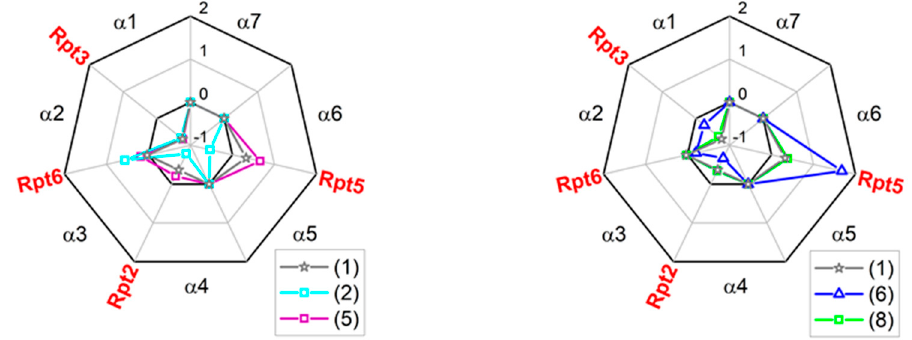
Figure 7. TAT1 derivatives competed with selected C-terminal tails of Rpt (Regulatory Particle ATPases) subunits for binding to specific α face pockets. The scores presented in radar plots were calculated as ((relative activation by the [x] and Rpt tail)-(theoretical sum of activation by [x] and Rpt tail)) / (theoretical sum of activation by [x] and Rpt tail), where [x] represent any TAT peptide. Score = 1 indicates a pure additive e ff ect of Rpt and TAT peptides, score < 1 suggests competition, score > 1 hints at synergy. (5) competed fairly specifically with Rpt3 tail, expected to dock in the α 1 / α 2 pocket, as evident from the strongly negative score. (1) and (8) added a weakly negative score for the Rpt2 tail to the presumed major competitor Rpt3. In turn, Rpt2 tail was a major competitor for (6). The poor activator (2) was the least specific ligand of the α face, competing with Rpt2, Rpt3, and Rpt5 tails. The positive scores for combinations of selected compounds with Rpt5 or Rpt6 tails indicated a presumed synergy in activation of the core. Average scores derived from three to six experiments are presented. The competition e ff ects were statistically significant (at least p < 0.05) for Rpt3 peptide and (1) and (8), as well as for Rpt2 peptide and (6).